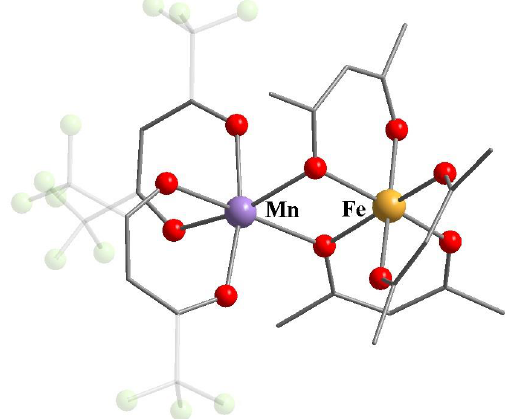
Scheme 8. Synthesis of polynuclear M(II)/Fe(III) β -diketonates.